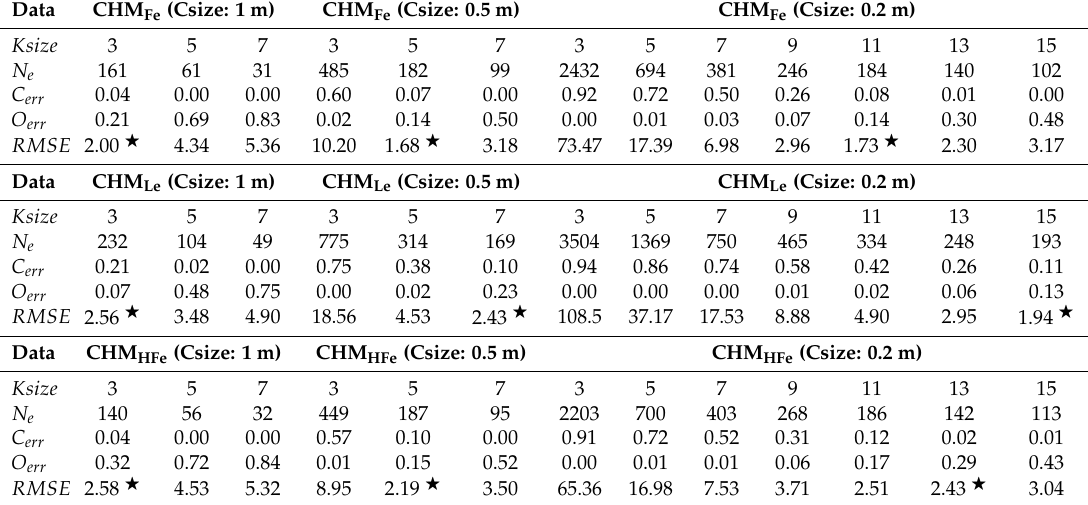
Table 1. The error assessment results of stand density from the local maximum method. The star ( (cid:70) ) marks the minimum RMSE for each CHM data type (CHM Fe , CHM Le , or CHM HFe ) with different Csize values (1, 0.5, or 0.2